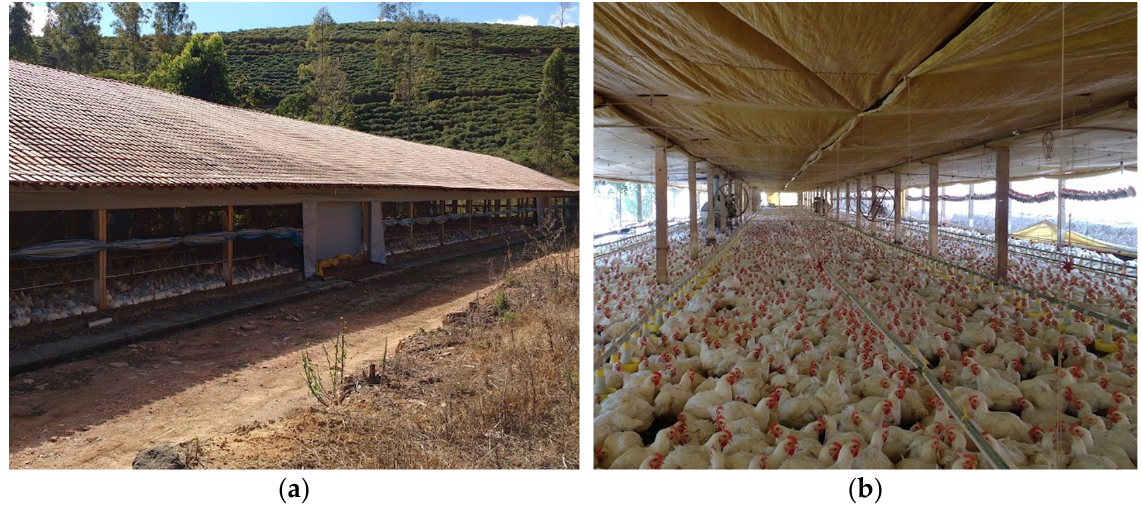
Figure 2. Open facilities for the production of broilers typical of the Zona da Mata of Minas Gerais (MG), Brazil; ( a ) external view and ( b ) internal view.